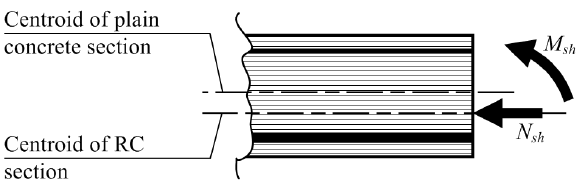
Fig. 9. Modelling the shrinkage in layered model by ficti- tious actions (axial force and bending